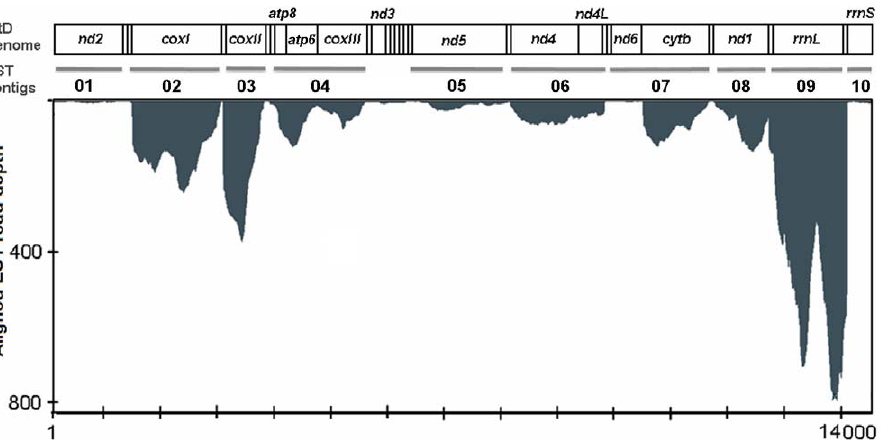
Figure 2. Transcript mapping to the mitochondrial genome. Transcript mapping of raw EST read data to respective positions on the M. vitrata mitochondrial genome (GenBank accession HZ751150), and assembled contigs representing polycistronic transcripts. The gene annotation and expression profile data for each of the contigs are presented in Table 4. Light strand encoded genes are indicated by asterisks (*), and arrows indicate the direction of transcription for polycistronic RNAs from the M. vitrata mitochondrial genome.